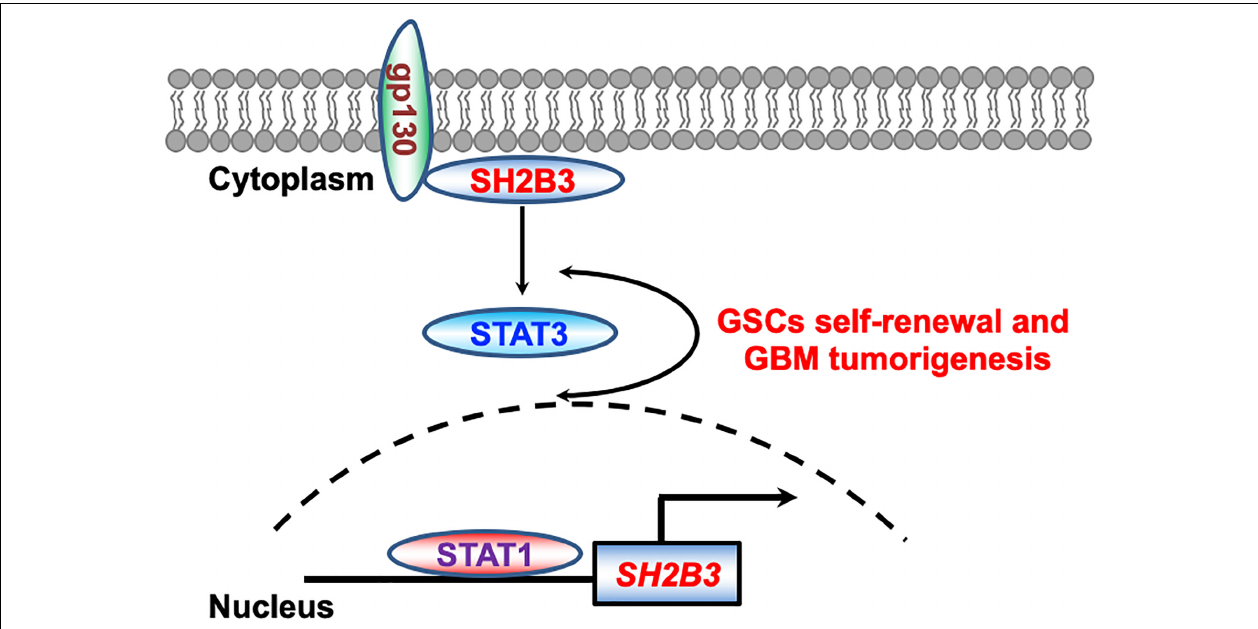
FIGURE 9 | Working model. STAT1 directly binds to SH2B3 promoter and activates SH2B3 expression in the transcriptional level. SH2B3 functions as an adaptor protein to physically bind to gp130 and activates the STAT3 signaling pathways, thereby facilitating glioblastoma progression in turn.